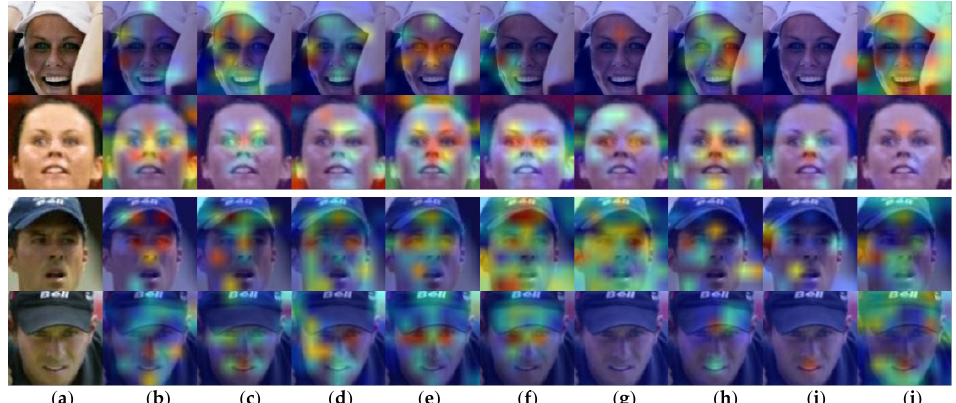
Figure 8. Two random face image pairs from the LFW dataset. The original image pairs are shown in ( a ), and the corresponding Grad-CAM visualisations for ConvFaceNeXt family members are illustrated from ( b ) to ( e ), while those for the other previous works are shown from ( f ) to ( j ), with all arranged column- wise from left to right. ( a ) Original face image pairs. ( b ) ConvFaceNeXt_PS. ( c ) ConvFaceNeXt_PE. ( d ) ConvFaceNeXt_TS. ( e ) ConvFaceNeXt_TE. ( f ) MobileFaceNet [11]. ( g ) ShuffleFaceNet 1 ×